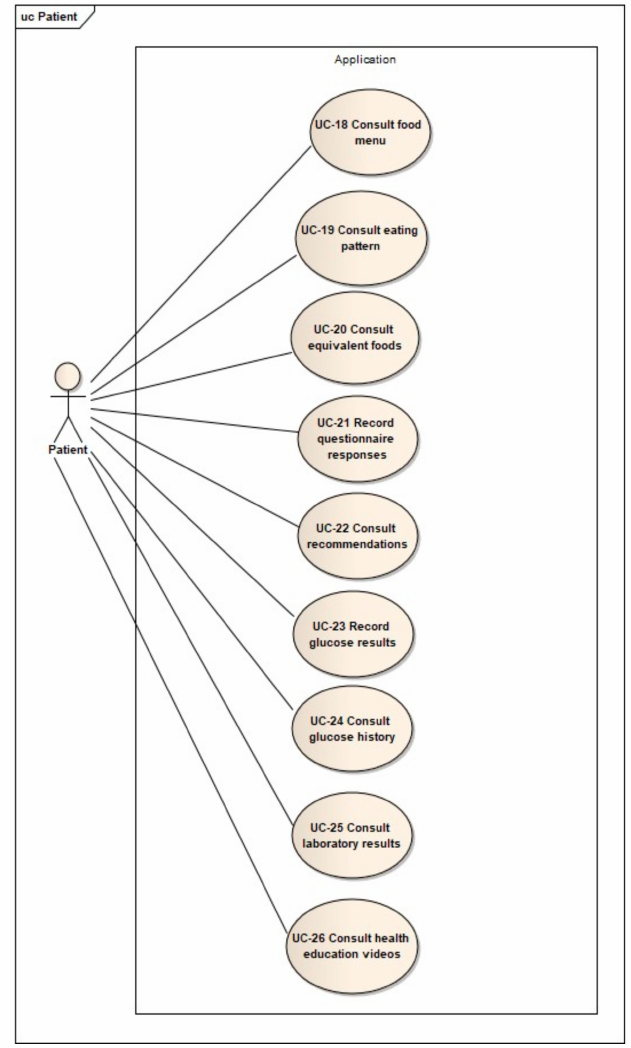
Figure 6. Patient application UC